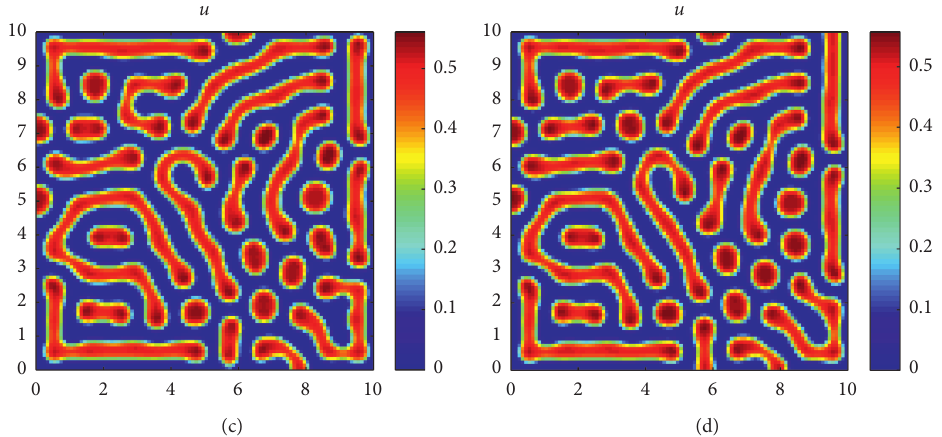
Figure 5: Mixture patterns obtained with model [1] for A � 0 . 02 and τ � 0 . 02. Time: (a) t � 100, (b) t � 500, (c) t � 2000, and (d) t �